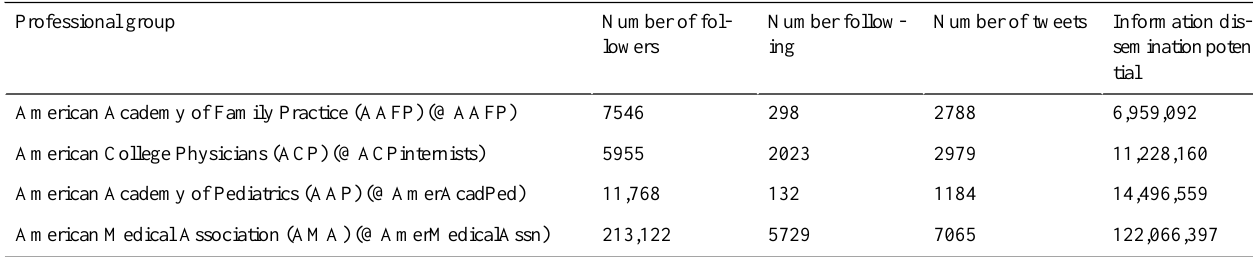
Table 2. Dissemination potential and professional group statistics during the study